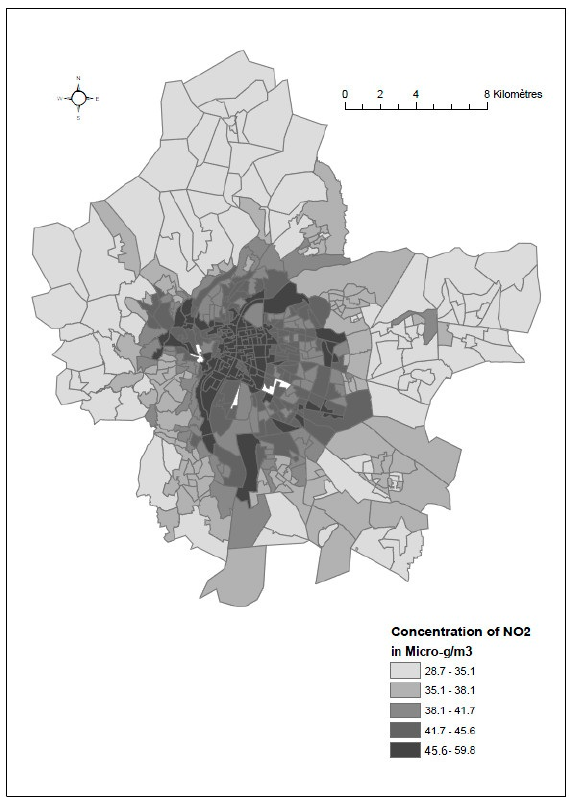
Figure 1. Spatial distribution of annual average NO 2 exposure over the period 2002–2012, at census block level based on quintiles of the distribution.